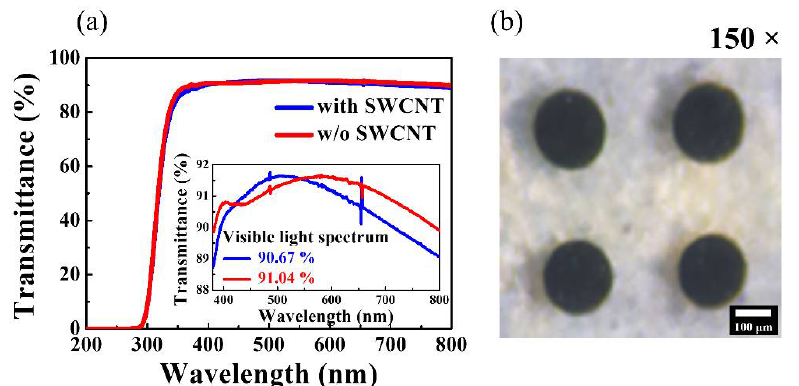
Figure 2. ( a ) Optical transmittance spectra of chitosan nanocomposite memristors with and without SWCNTs. The inset shows the spectra between transmittance values of 88% and 92% for visible wavelengths (380−800 nm). ( b ) Optical microscopy image of chitosan–SWCNT nanocomposite lengths (380–800 nm). ( b ) Optical microscopy image of chitosan–SWCNT nanocomposite memristors.